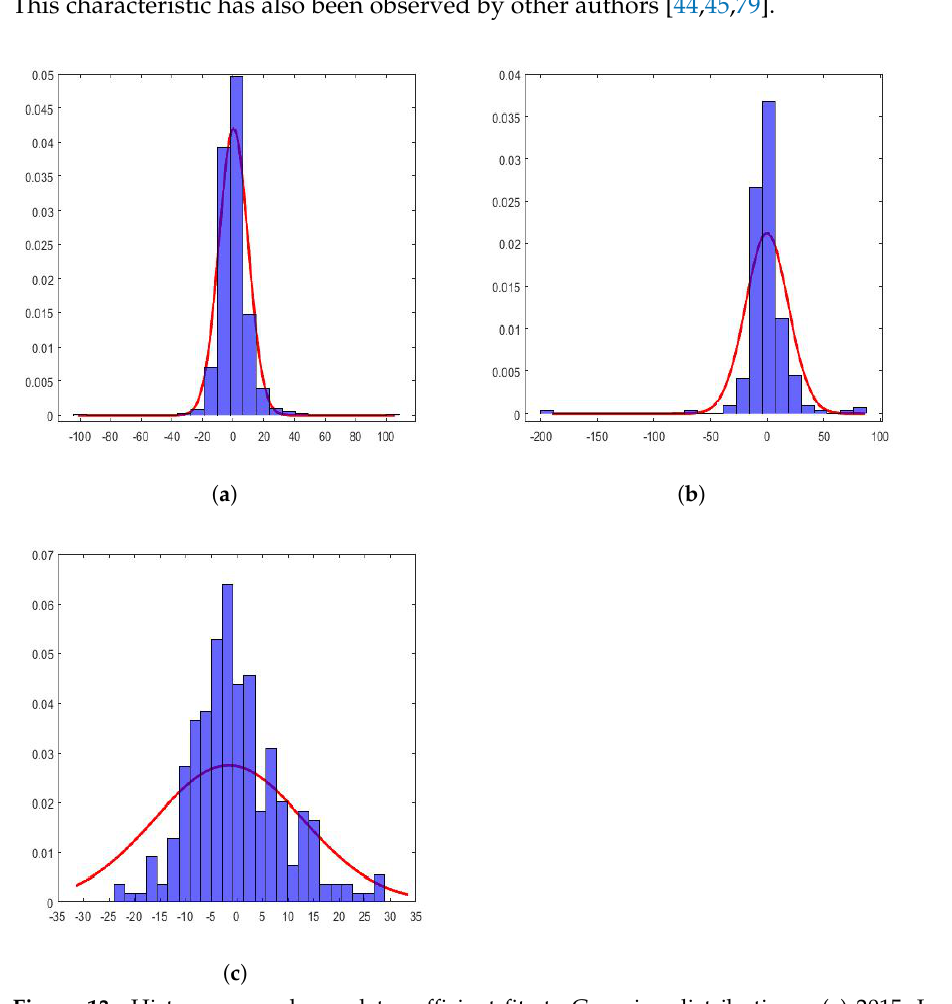
Figure 13. Histograms and wavelet coefficient fits to Gaussian distributions: ( a ) 2015, Level 1, Subsequence 1; ( b ) 2017, Level 3, Subsequence 2; ( c ) 2018, Level 5, Subsequence